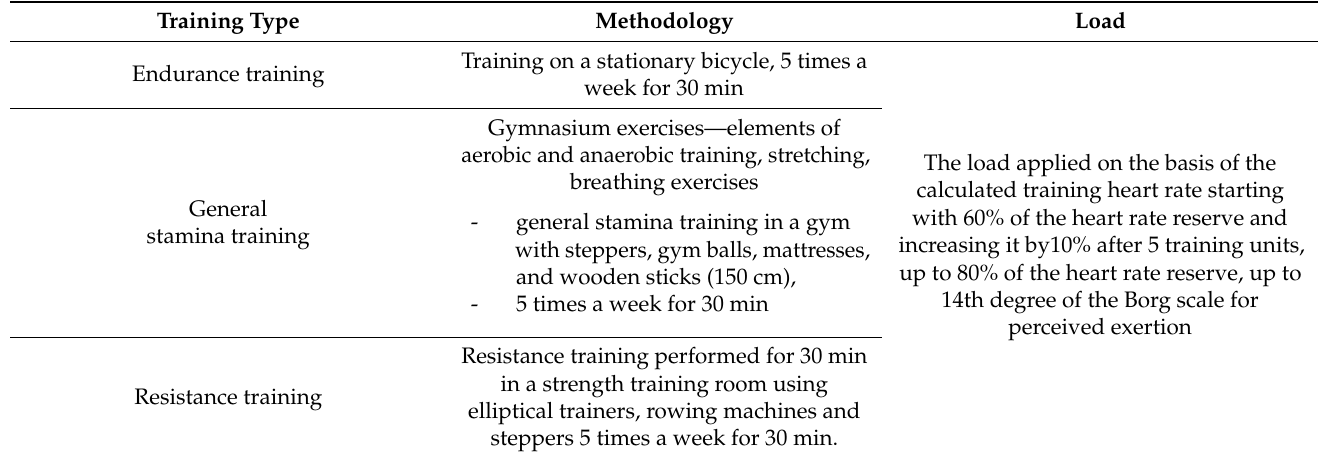
Table 1. Training following ESC